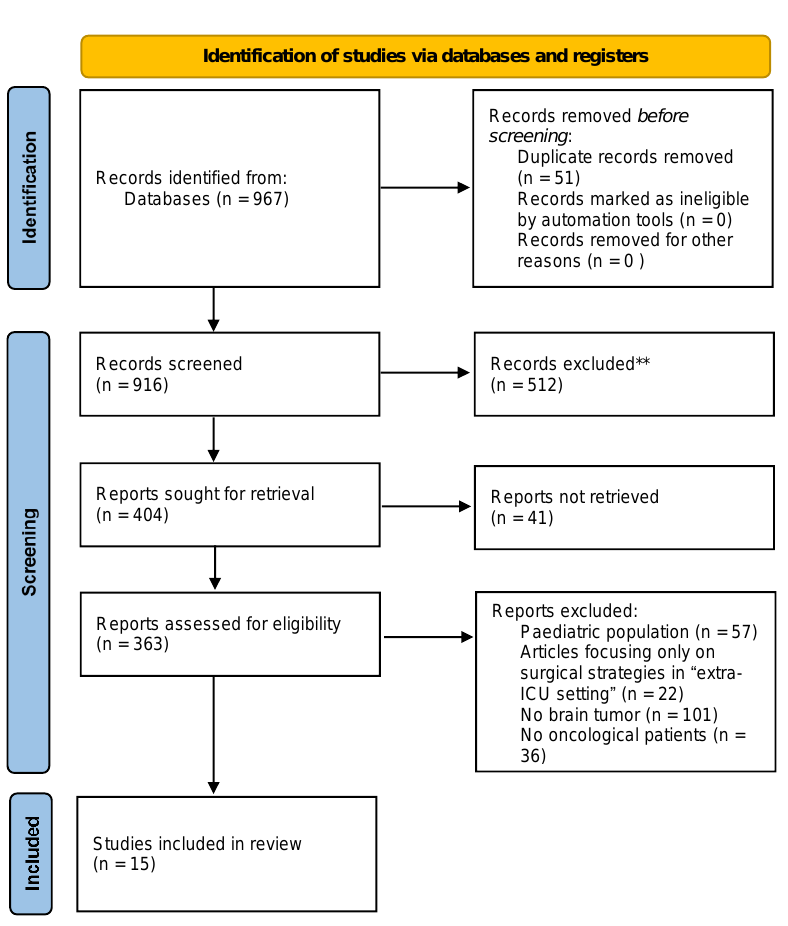
Figure 1. PRISMA flow chart.